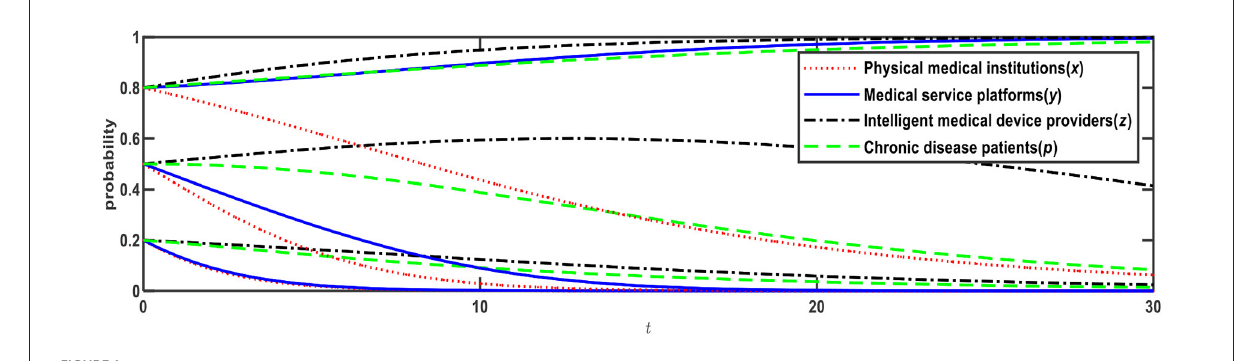
FIGURE1 Evolution of E1 (0,0,0,0) and E12